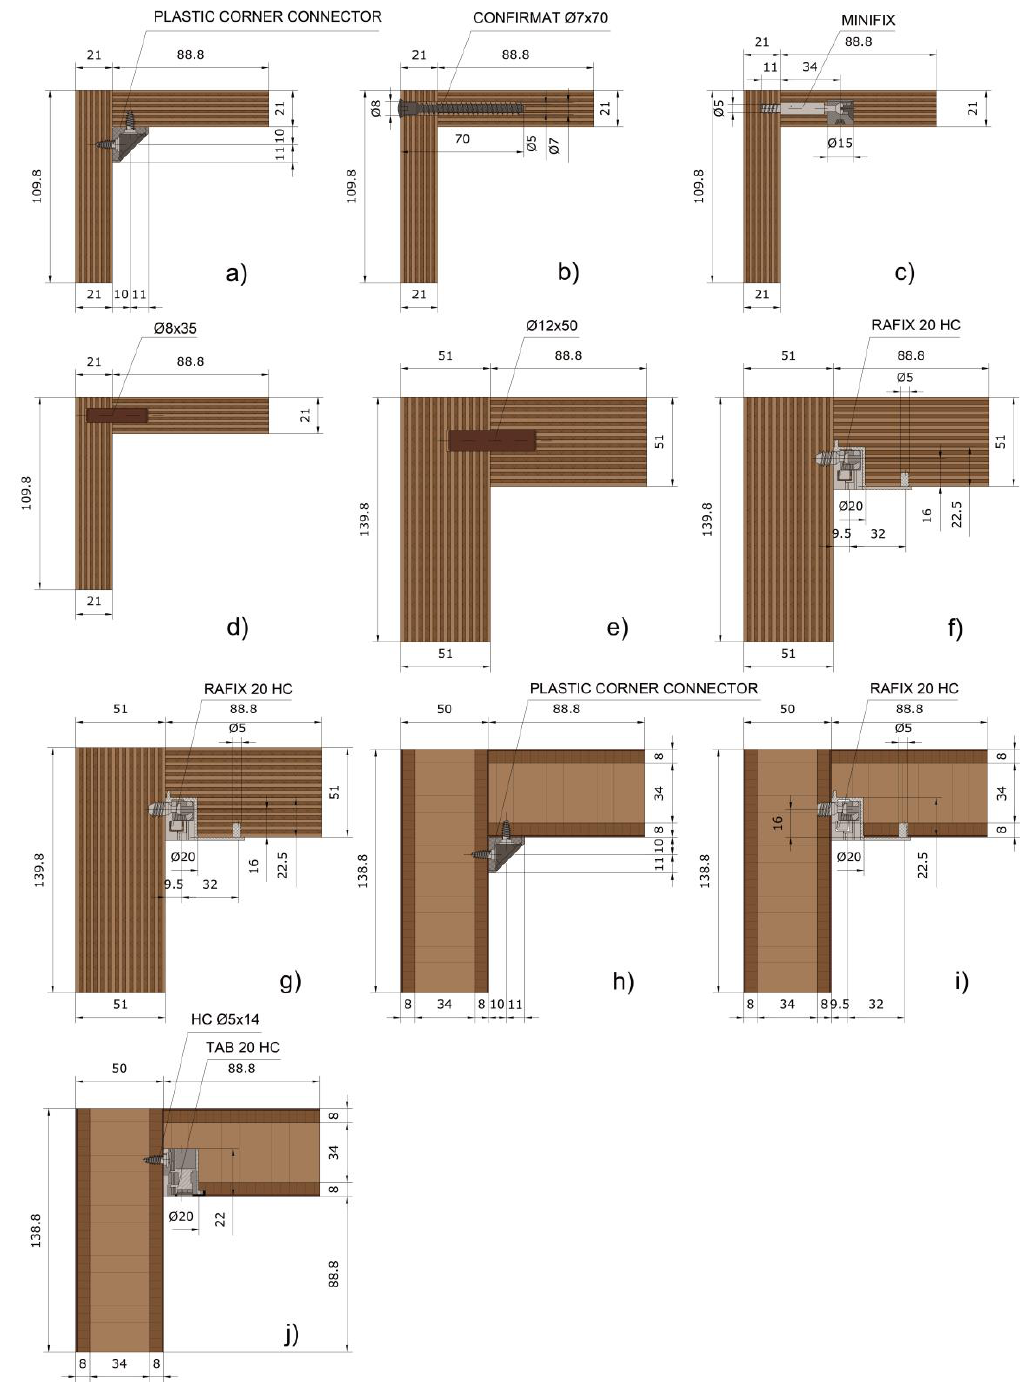
Figure 4. Corner joints made of lightweight panels: ( a ) Multi-layer panel (21 mm) made of veneer and corrugated